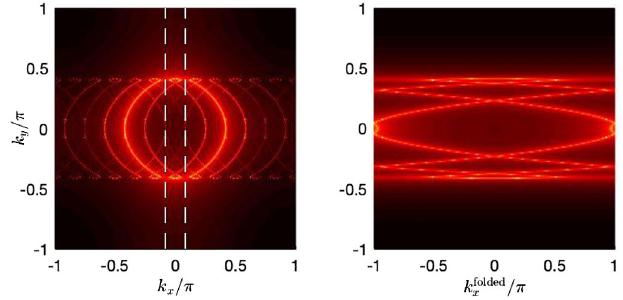
FIG. 5. Simulated fermionic spectral function ρ ð k ; E ¼ 0 Þ from a lattice nearest-neighbor hopping model subject to a PDW order parameter. For the normal state, we use the dispersion ϵ ð k Þ ¼ − t k k − μ , and we take the local PDW 0 ð cos x þ cos y Þ coupling with wave vector Q as (cid:2) Δ sin k x þ i sin k y Þ PDW ð c † : c : . We set the parameters as t 1 , μ ¼ − 1 . 25 , c † 0 ¼ − k þ H k Δ 0 . 052 , and Q ¼ π = 6 . In the left panel, we plot the PDW ¼ spectral function in the original Brillouin zone. In the right panel, we plot the spectral function in the folded Brillouin zone (the region between the dashed lines in the left panel) with a new lattice constant a Q ¼ a 0 × 2 π =Q . Compared with Fig. 4, the FS here can be viewed as a small perturbation of the original (circular) FS formed by composite